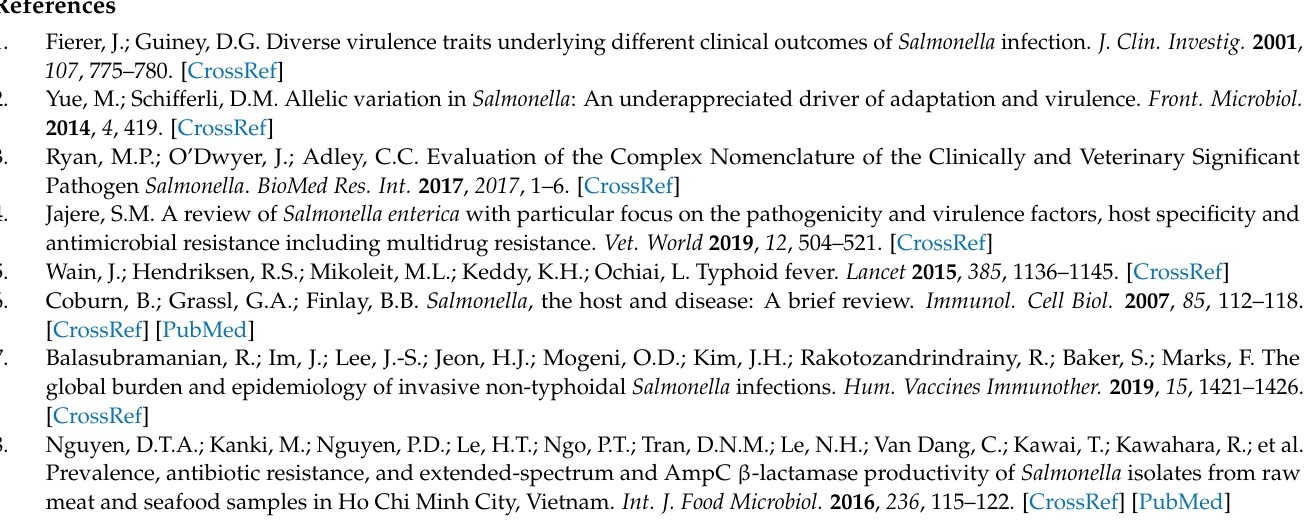
.3390/microorganisms9112239/s1, Figure S1: Schematic circular genome of SE211 and the cluster orthologous groups (COG) of genes, including a chromosome (A and C) and a plasmid (B and D), Figure S2: Comparison of pSE211 (the plasmid from SE211) with pSENV (the plasmid from P125109), Table S1: Information of nine S. enterica isolates, Table S2: Primers used for quantitative Table S3: Oral infection (2.5 × 10 8 CFU) and secondary infection (2.5 × 10 7 CFU) of nine S. enterica strains to chicken, Table S4: Virulence associated genes in SE211, Table S5: Predicated Salmonella pathogenicity islands (SPIs) in SE211, Table S6: The summary of the predicated prophages in the genome of SE211, Supplementary Material S1: GI1-31, Supplementary Material S2: Prophage detail, Supplementary Material S3: MST, Supplementary Material S4: CRISPR-Cas system targets predicated by